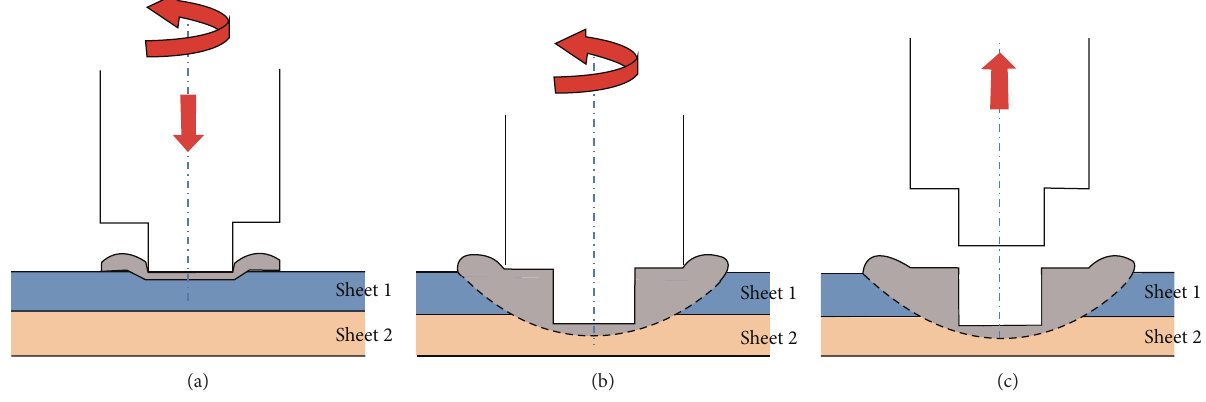
Figure 1: Illustration of the FSSW process: (a) plunging, (b) stirring, and (c) retracting [9].